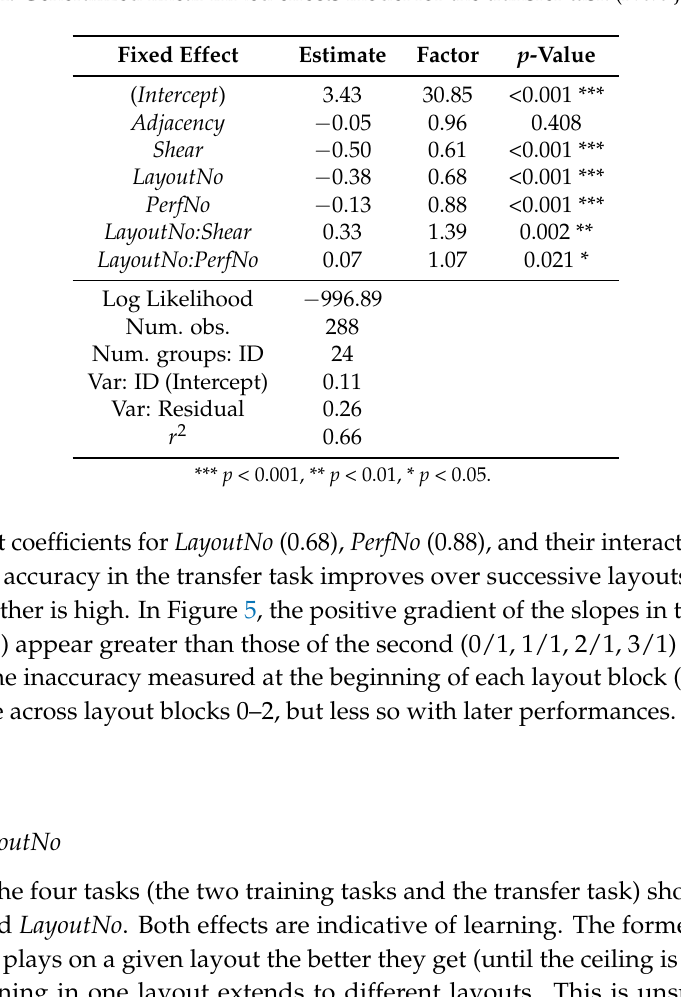
Table 4. Generalized linear mixed effects model for the transfer task ( Frère Jacques